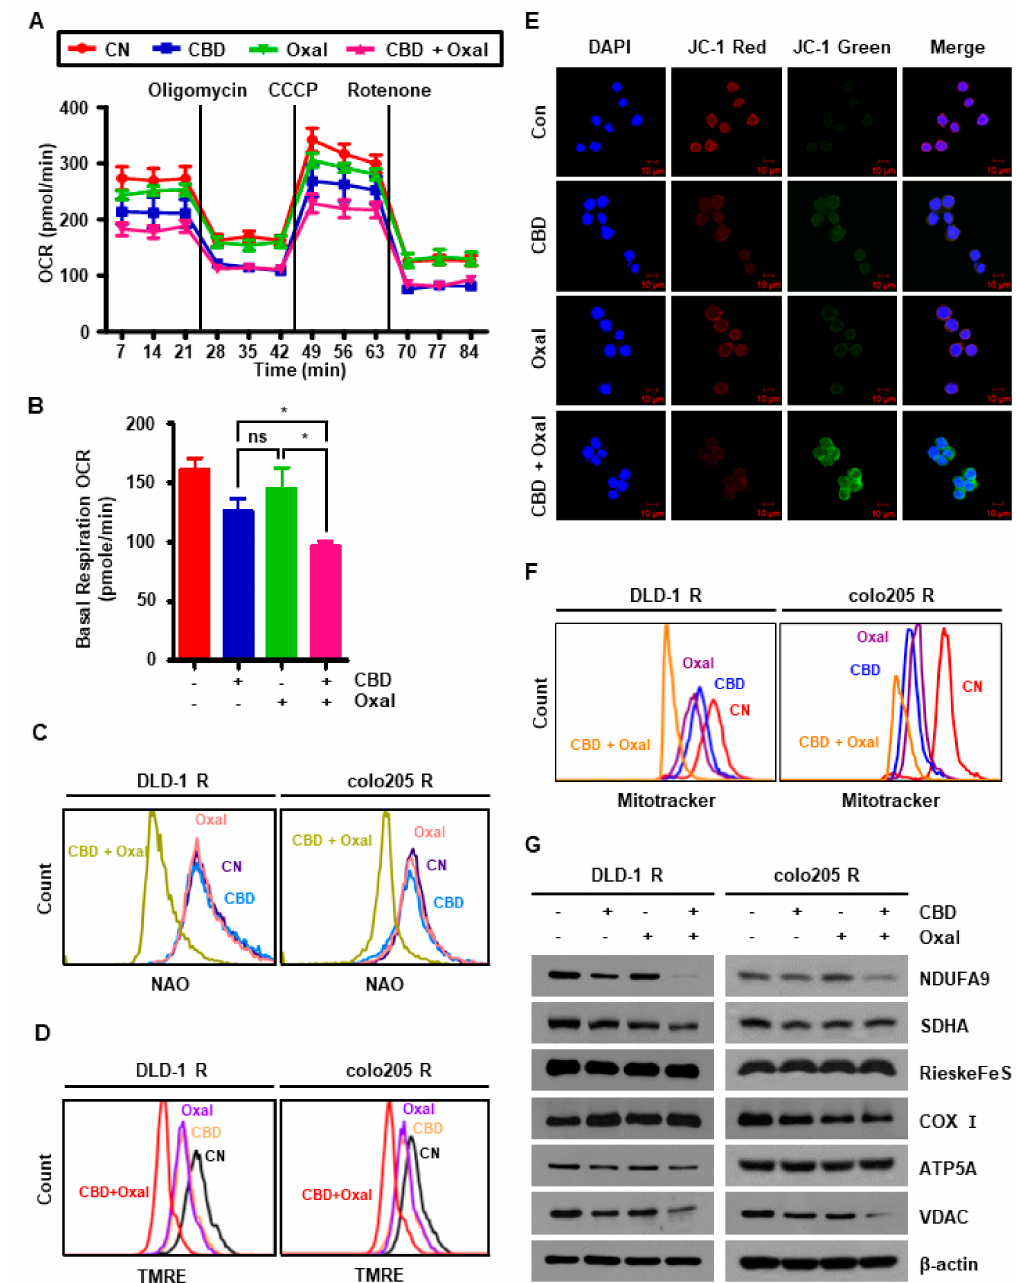
Figure 4. Combination of oxaliplatin and CBD leads to mitochondrial dysfunction. ( A , B ) Oxygen consumption rate (OCR) was measured in colo205 R cells treated with oxaliplatin and CBD using XF-24 extracellular flux analyzer. ( A ) OCR levels were detected following the addition of 2 µ g / mL oligomycin, 2.5 µ M carbonyl cyanide m-chlorophenyl hydrazine (CCCP), and 3 µ M rotenone. ( B ) OCR was quantified during basal respiration. * p < 0.05. ( C–F ) Oxaliplatin and CBD-treated cells were stained with ( C ) 5 µ M nonyl acridine orange (NAO), ( D ) 500 nM tetramethylrhodamine, ethyl ester, perchlorate (TMRE), ( E ) 5,5,6,6-Tetrachloro-1,1,3,3-tetraethylbenzimidazolylcarbocyanine iodide (JC-1) (scale bar, 10 µ m), or ( F ) MitoTracker and analyzed by flow cytometry and immunocytochemistry. ( G ) Cells were treated with CBD and oxaliplatin for 24 h and then the protein levels of mitochondrial electron transport chain (ETC)-related proteins were measured by western